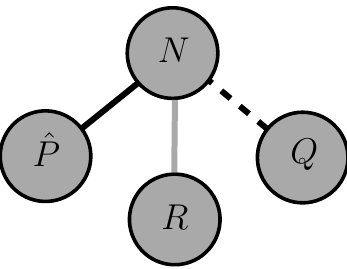
Figure 2 . The building block of our theories. The solid black line represents a (4 ; 4) hypermultiplet. The grey line represents a (0 ; 4) hypermultiplet. The dashed line represents a (0 ; 2) Fermi multiplet. Inside the gauge group SU( N ) run (4 ; 4) SUSY vector multiplets. The groups SU( ^ P ), SU( Q ) and SU( R ) can be gauge or